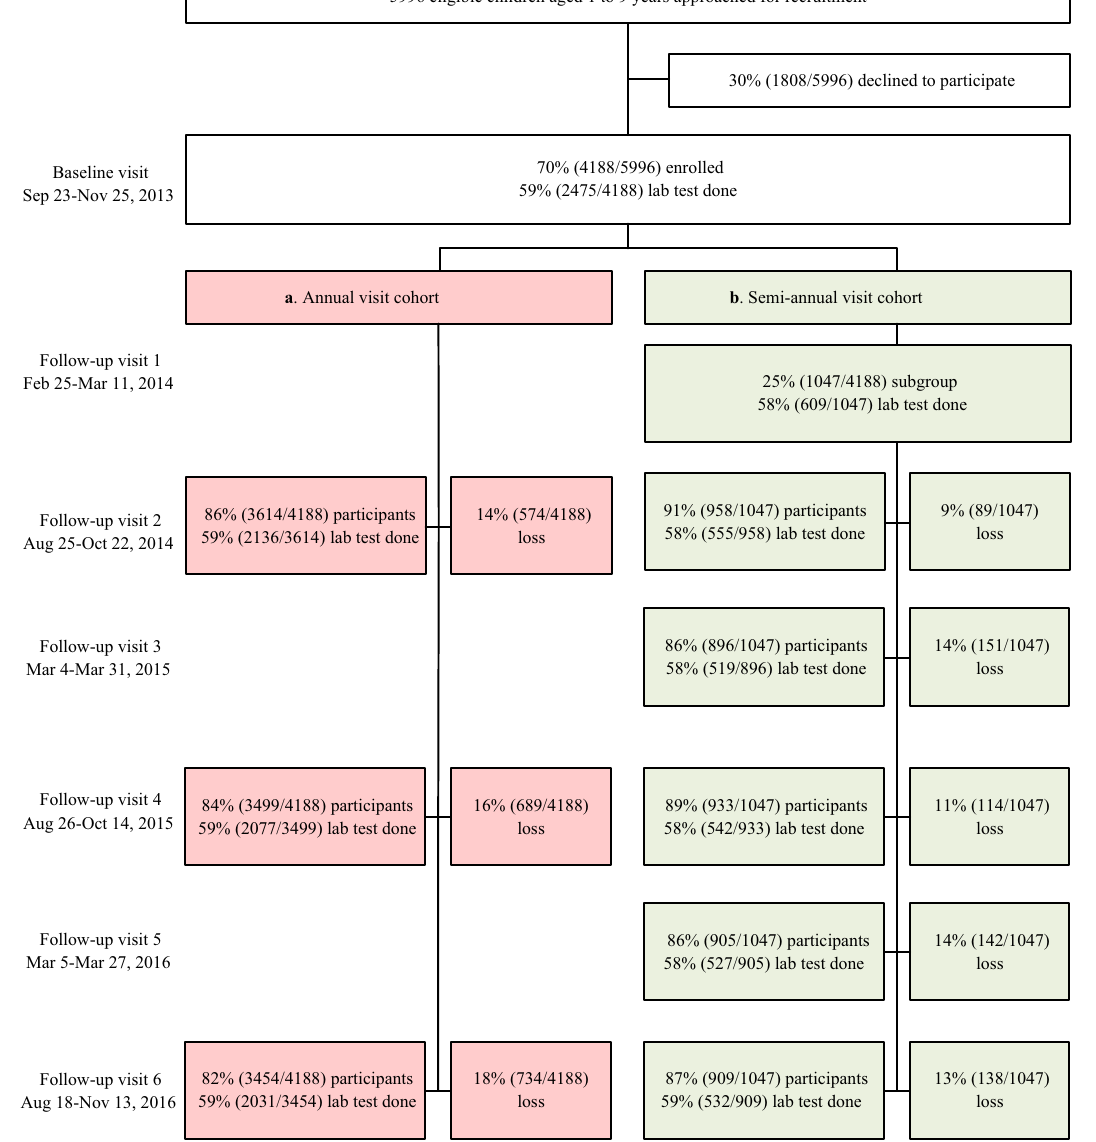
Fig. 1 | Flowchart of recruitment for all participants aged 1 – 9 years and the follow-up visit rates ( N =4188). a Regular follow-up visits between August and November every year (i.e., annual visit) for all enrolled participants during